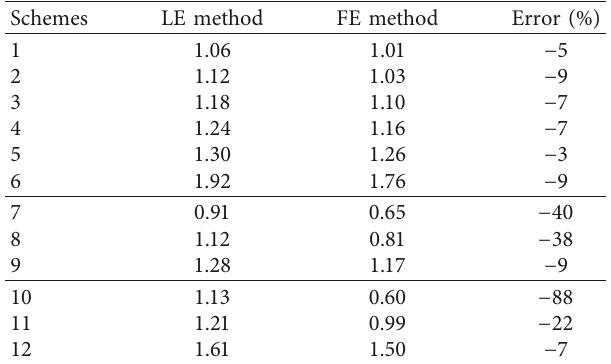
Figure 6: Shear stress distribution on the sliding surface with changes of c and φ. (a) φ the change in value of c ; (c) c Table 6: Influence of progressive failure on safety factors and error